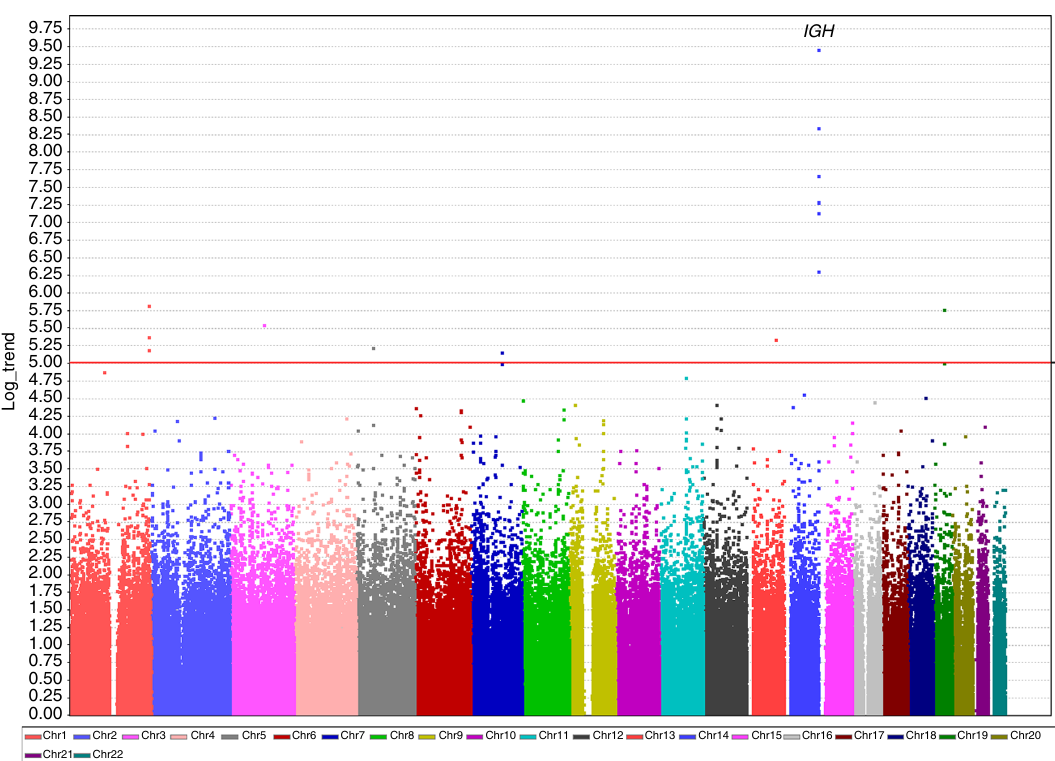
Fig. 1 Manhattan plots for genome-wide SNPs associated with anti-PEG IgM responses. Results of genome-wide association analysis ( − log 10 P ) shown in chromosomal order for 557,394 SNPs tested for association in initial sample of 177 cases (anti-PEG IgM positive) and 492 controls (double-negative for anti-PEG IgM and IgG). The x axis represents each of the SNPs used in the primary scan. The y axis represents the − log 10 P -value of the trend test. Horizontal lines indicate − log 10 P = 5. Signals in the IGH regions are